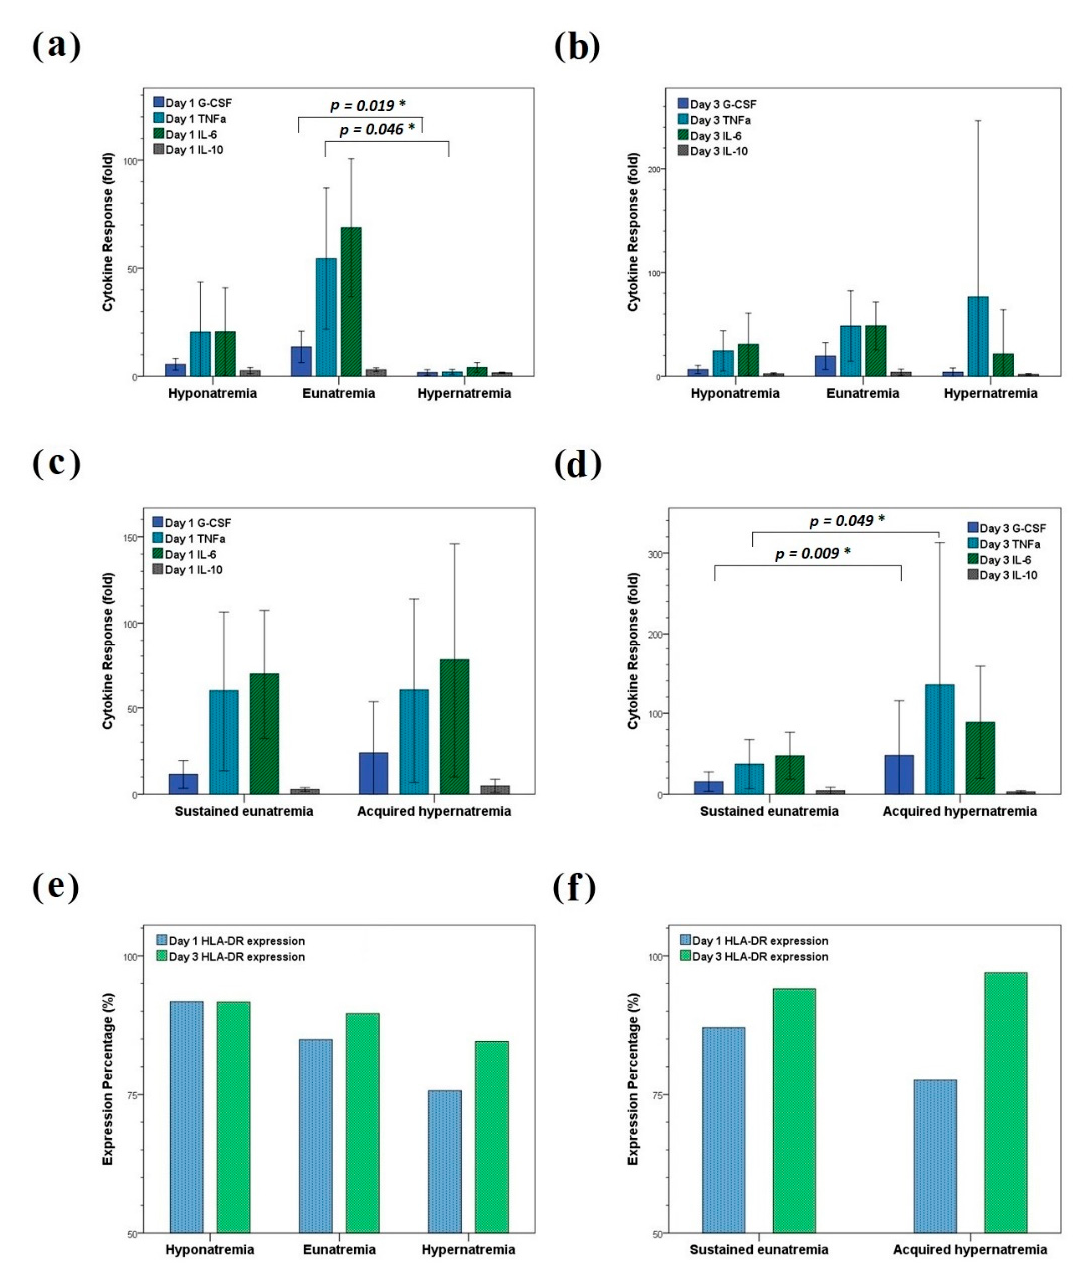
Figure 3. LPS-stimulated cytokine response and HLA-DR-expressing monocyte percentage. ( a – d ) Bar charts for LPS-stimulated cytokine response (unit: fold) in patients with hyponatremia, eunatremia, and hypernatremia on ICU days 1 ( a ) and 3 ( b ) and in patients with sustained eunatremia and acquired hypernatremia on days 1 ( c ) and 3 ( d ). Error bars represent 95% confidence intervals. The LPS-stimulated cytokine response was calculated by dividing the cytokine level after LPS stimulation with that before stimulation. ( e , f ) Bar charts of day 1 and 3 HLA-DR-expressing monocyte percentage in patients with hyponatremia, eunatremia, and hypernatremia ( e ) and in patients with sustained eunatremia and acquired hypernatremia ( f ). Abbreviations: IL, interleukin; LPS: lipopolysaccharide; TNF- α : tumor necrosis factor- α ; G-CSF, granulocyte colony-stimulating factor. * p < 0.05.